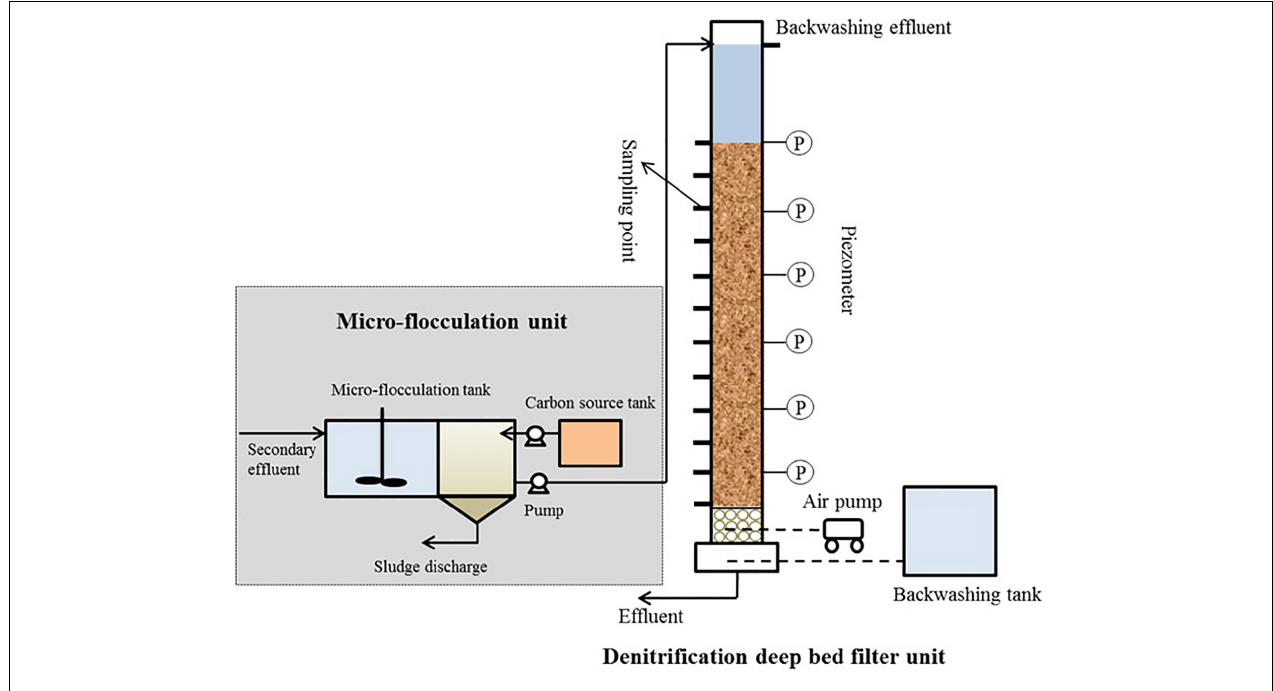
FIGURE 1 | Schematic diagram of the denitrification deep bed filter.